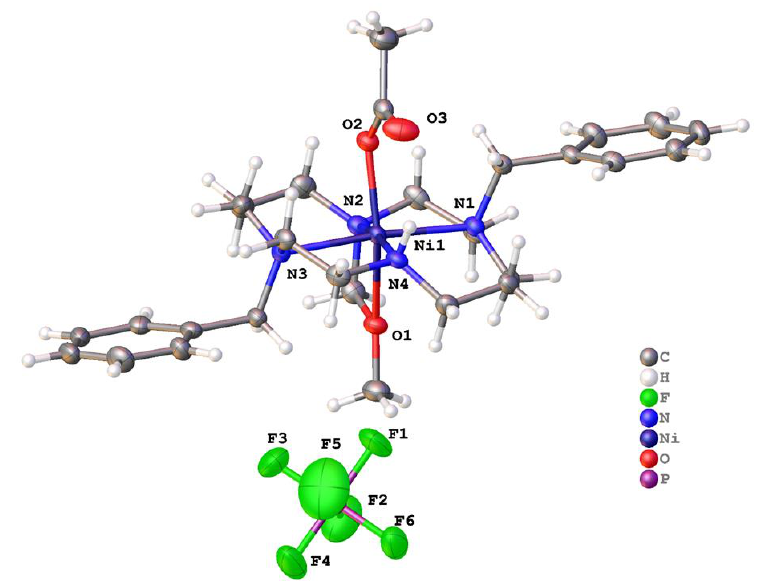
Figure 13. Asymmetric unit of [Ni( 2′ )(OAc)](PF 6 ) · MeCN with atoms drawn as 50% probability ellipsoids.